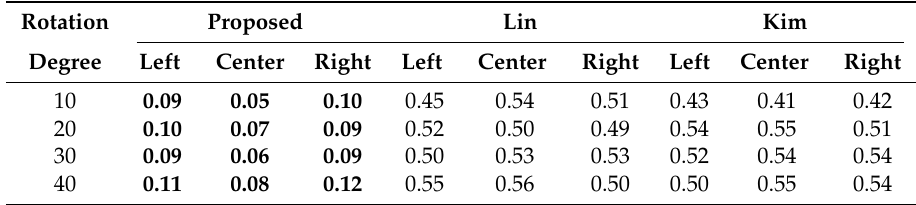
Table 10. Average BER for rotation